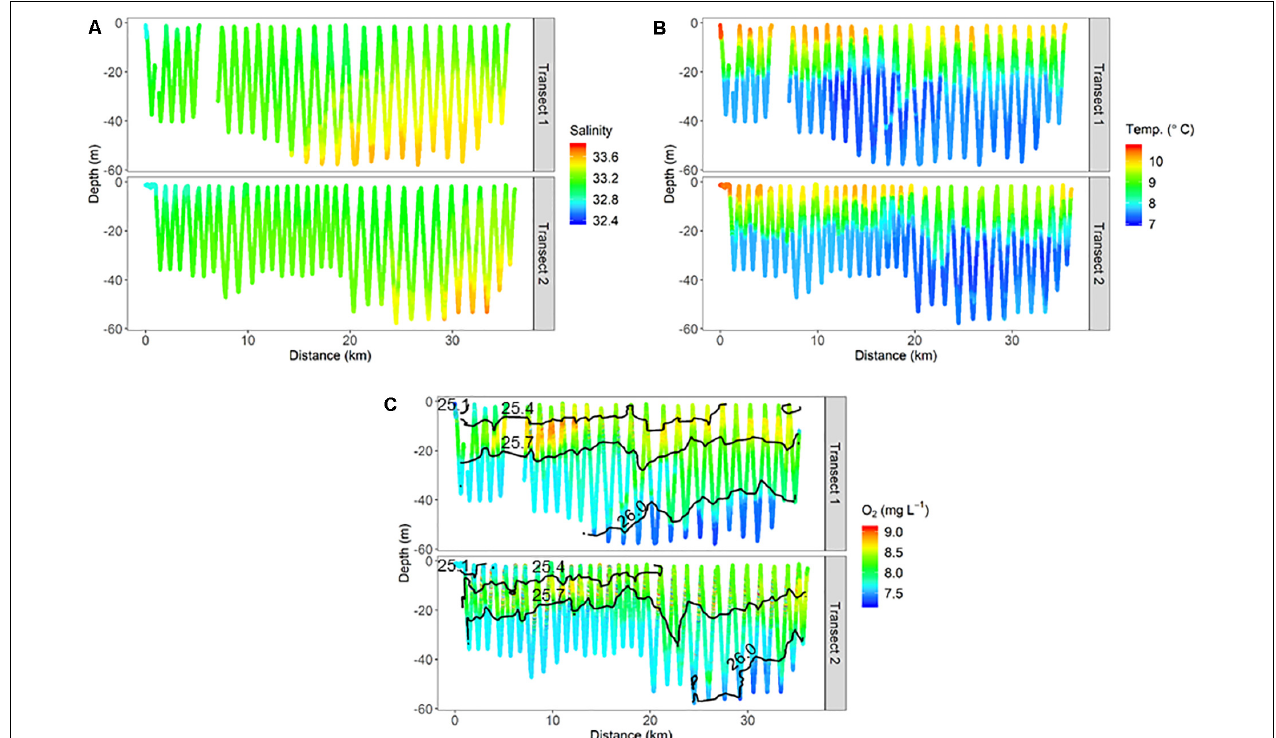
FIGURE 4 | Physical oceanographic conditions from ISIIS tow #3 including, (A) salinity, (B) temperature, and (C) dissolved oxygen. Isopycnals located in panel C (1025.1, 1025.4, 1025.7, and 1026.0 kg m − 3 ) are displayed as a reference.